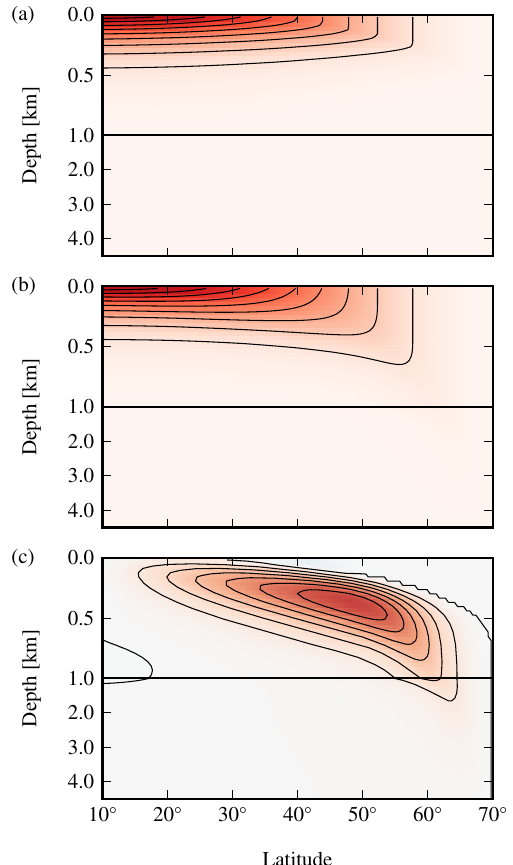
Fig. 6. Overturning stream functions ˆ ψ (nondimensional) for (a) ˆ κ v = 10 − 5 (contour interval 1 × 10 − 4 ), (b) ˆ κ v = 10 − 4 (contour interval 5 × 10 − 4 ), and (c) ˆ κ v = 10 − 3 (contour interval 20 × 10 − 4